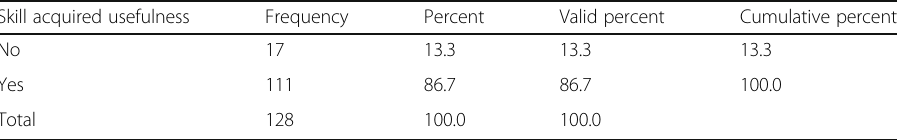
Table 8 Acquired skill is useful for your work Skill acquired usefulness Frequency Percent Cumulative